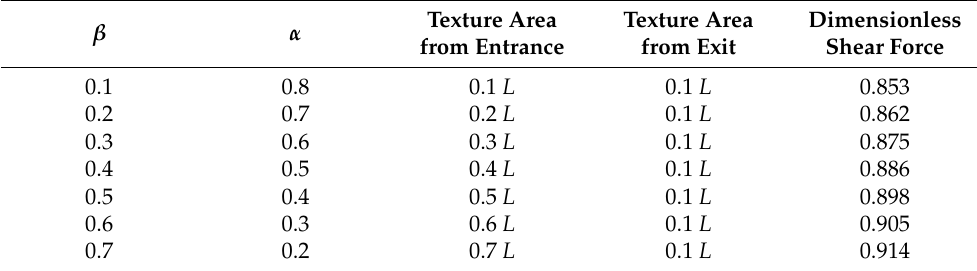
Table 3. Dimensionless shear forces for the streamwise local texture state wall. β α